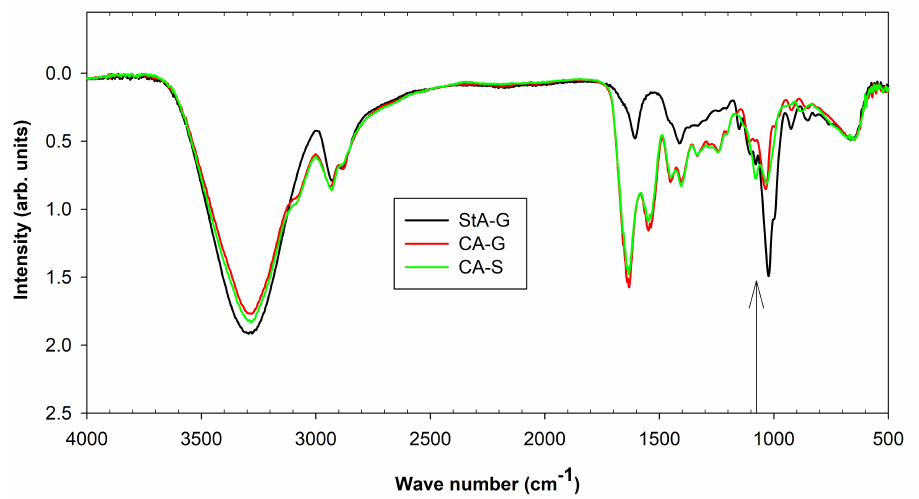
Figure 2. FTIR spectra of biofilms: StA-G ( ), CA-G ( ), and CA-S ( ). The arrow indicates a new peak at 1078 cm − 1 in the CA-S